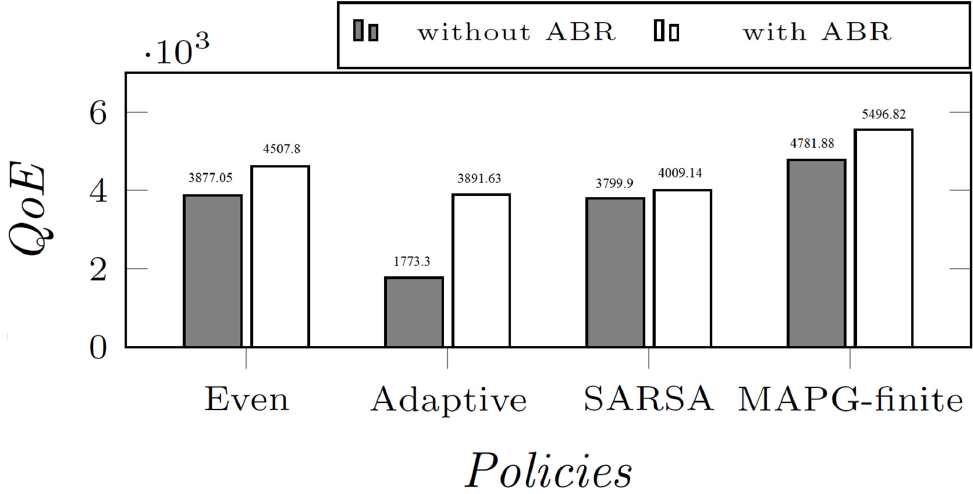
Figrue 9 Figure 9. QoE reward comparisons with ABR feature activated/deactivated. The total download bandwidth is 1500 KB/s. MAPG-finite achieves 21.94%, 41.25%, and 37.11% more than the “Even”, “Adaptive”, and SARSA